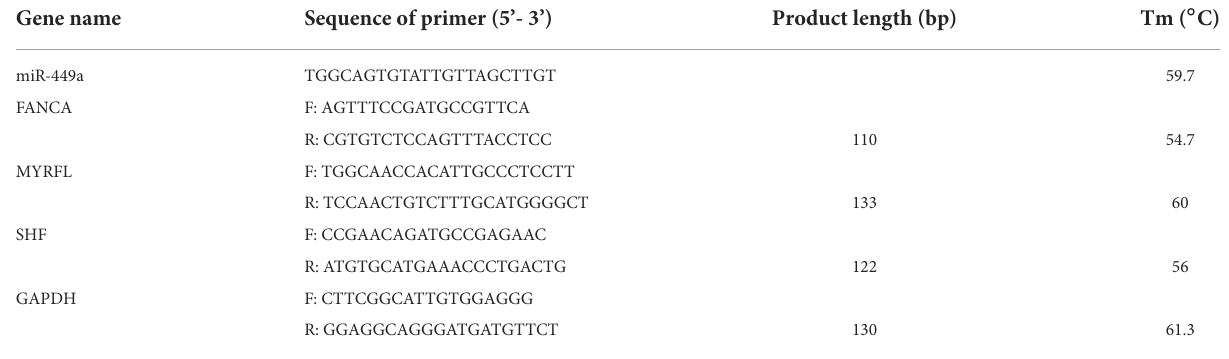
TABLE 5 The information on the primers used in qRT-PCR validation.